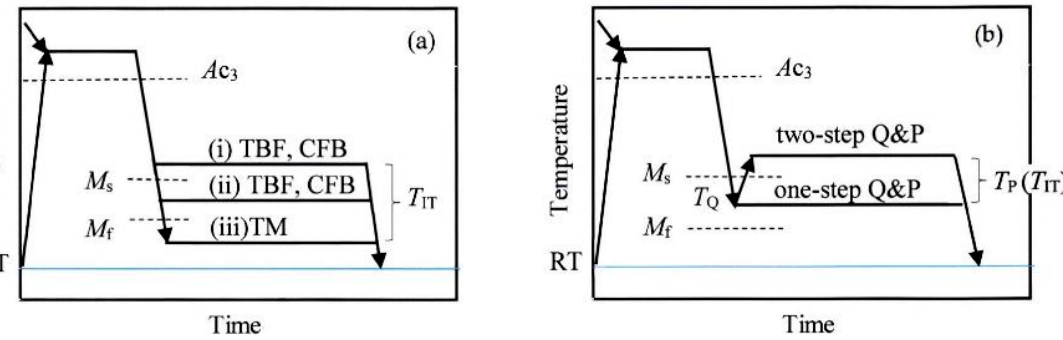
Figure 2. Heat treatment diagrams of ( a ) TBF, CFB and TM steels [52] and ( b ) one-step and two-step Q&P steels [20]. T IT , T Q , T P , A c 3 , M s , and M f are isothermal transformation temperature, quenching temperature, partitioning temperature, the austenite-finish temperature on heating, martensite-start temperature, and martensite-finish temperatures, respectively.